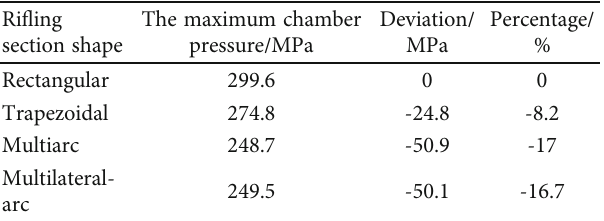
Table 8: Maximum chamber pressures corresponding to di ff erent cross-sectional pro fi